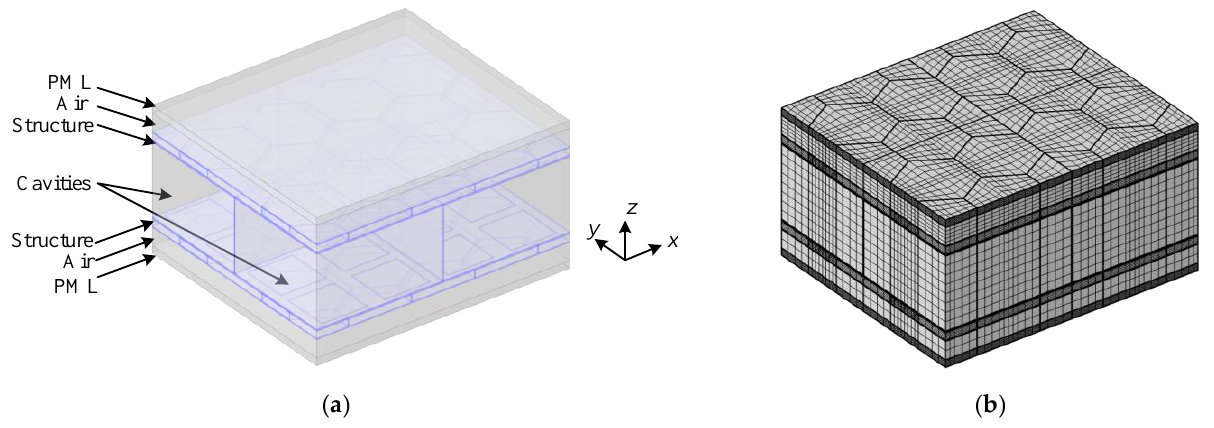
Figure 8. FE model of one periodic element without piezoelectric patches: ( a ) transparent model and ( b ) mesh model.